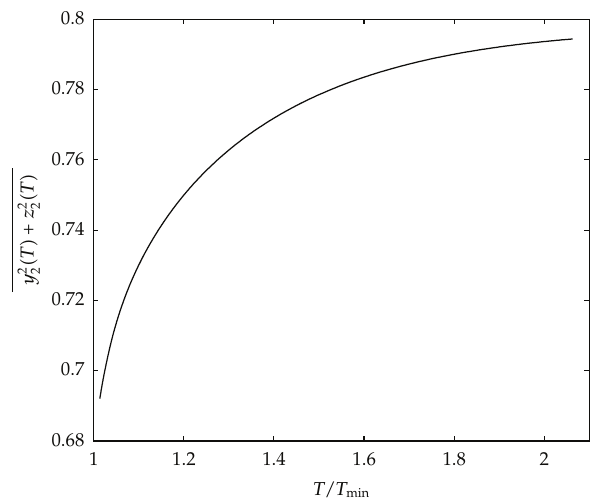
Figure 11: Evolution of the final contrast as a function of the transfer